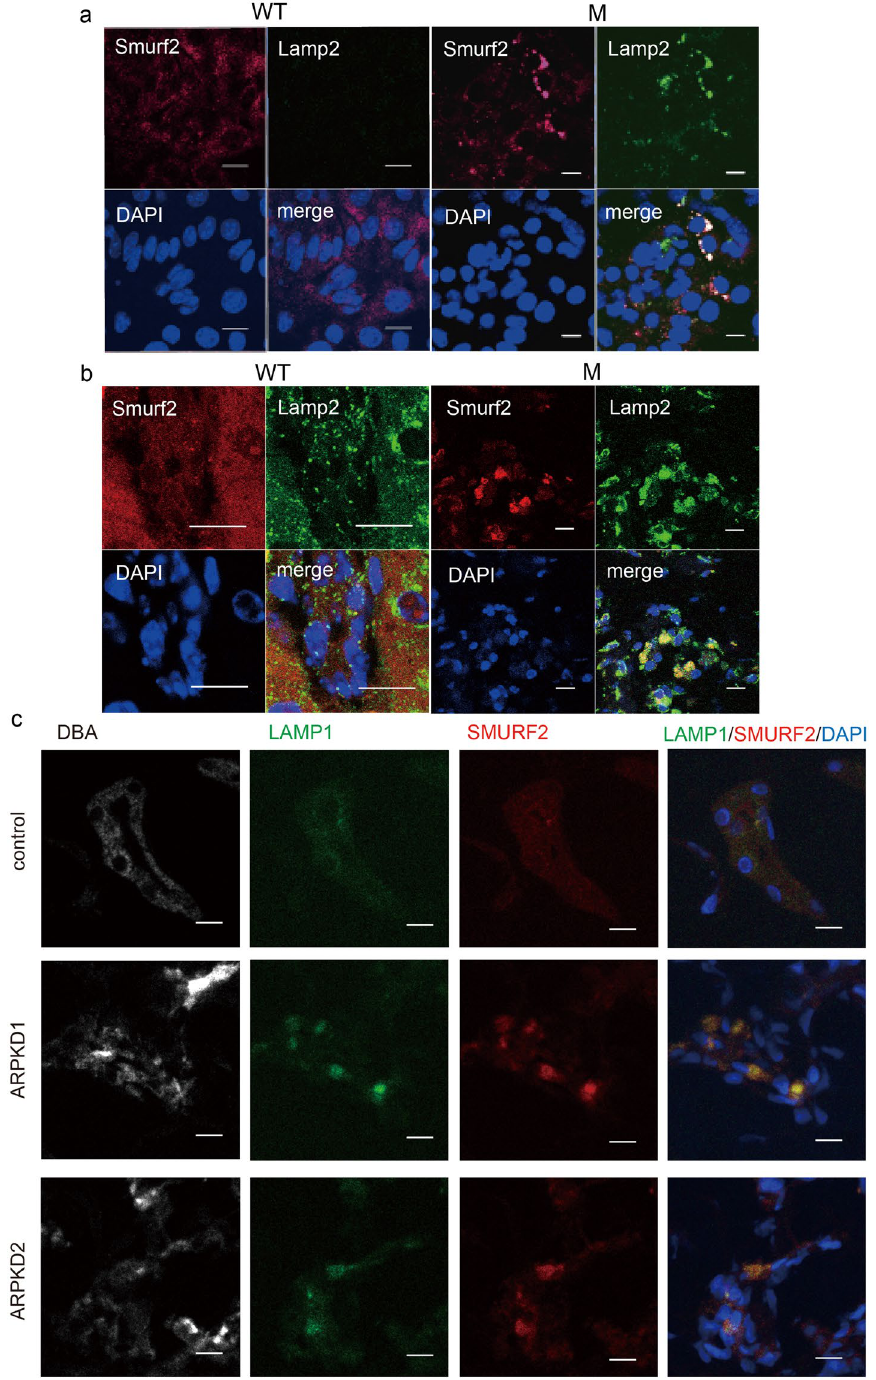
Figure 3. Smurf2 is mis-localized in Pkhd1 mutants. ( a ) Sub-cellular localization of Smurf2 (red), Lamp2 (green) and DAPI (blue) in primary cultures of collecting duct cells of wild type (WT) and Pkhd1 del3-4/del3-4 (M) mouse kidneys. Nuclei are stained with DAPI. Scale bars, 10 μ m. ( b ) Wild type (WT) and Pkhd1 del3-4/del3-4 mouse kidneys stained for Smurf2 (red), Lamp2 (green), and DAPI (blue). Scale bars, 10 μ m. ( c ) Kidney specimens from human control (control) and two different ARPKD donors (ARPKD1, ARPKD2) stained for DBA (grey), LAMP1 (green), SMURF2 (red) and DAPI (blue). Scale bars, 20 μ